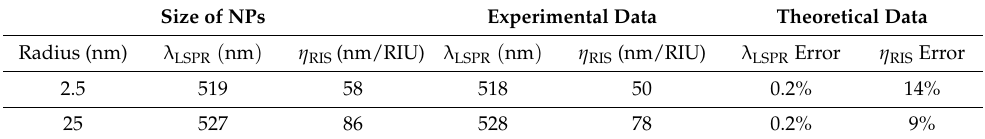
Table 1. The LSPR peak wavelength and bulk sensitivity values of gold spherical NPs of different size. Size of NPs Experimental Data Theoretical Data